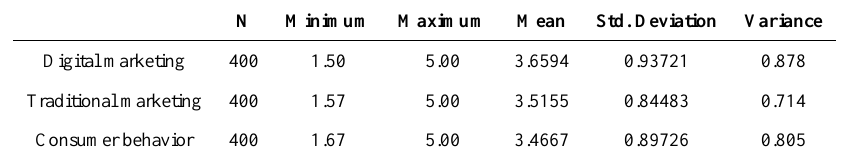
Table 2. Descriptive Statistics for Compliance for Digital Marketing, Traditional Marketing and Consumer Behavior N